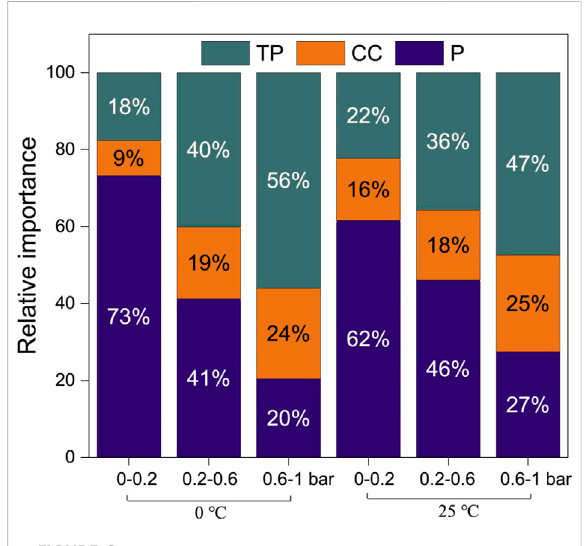
FIGURE 6 The relative importance of integrated in fl uential factors at different pressure ranges (TP, CC and p represented textural properties, chemical compositions and pressure, respectively) (Zhu et al.,